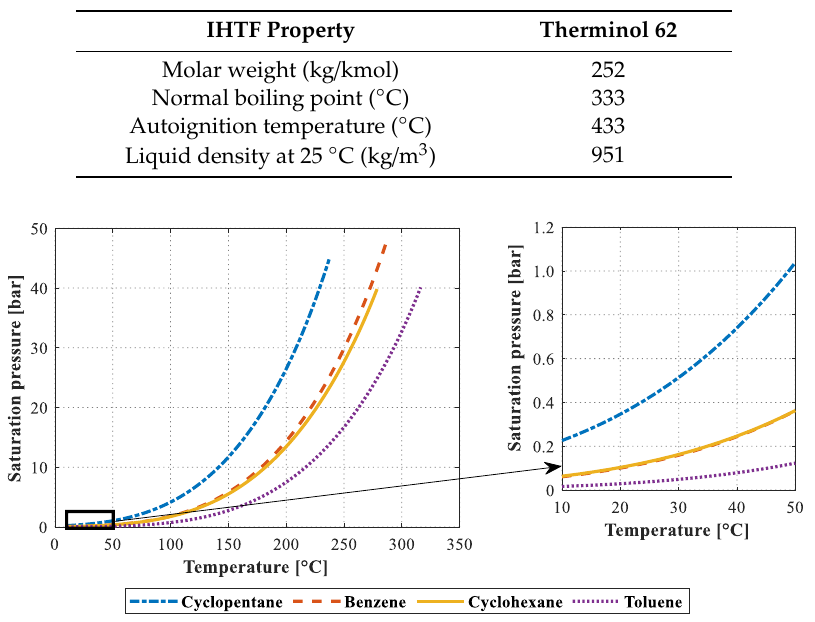
Figure 7. Pressure-temperature saturation curves of selected hydrocarbons. Table 2. Main properties of selected organic fluids [21].